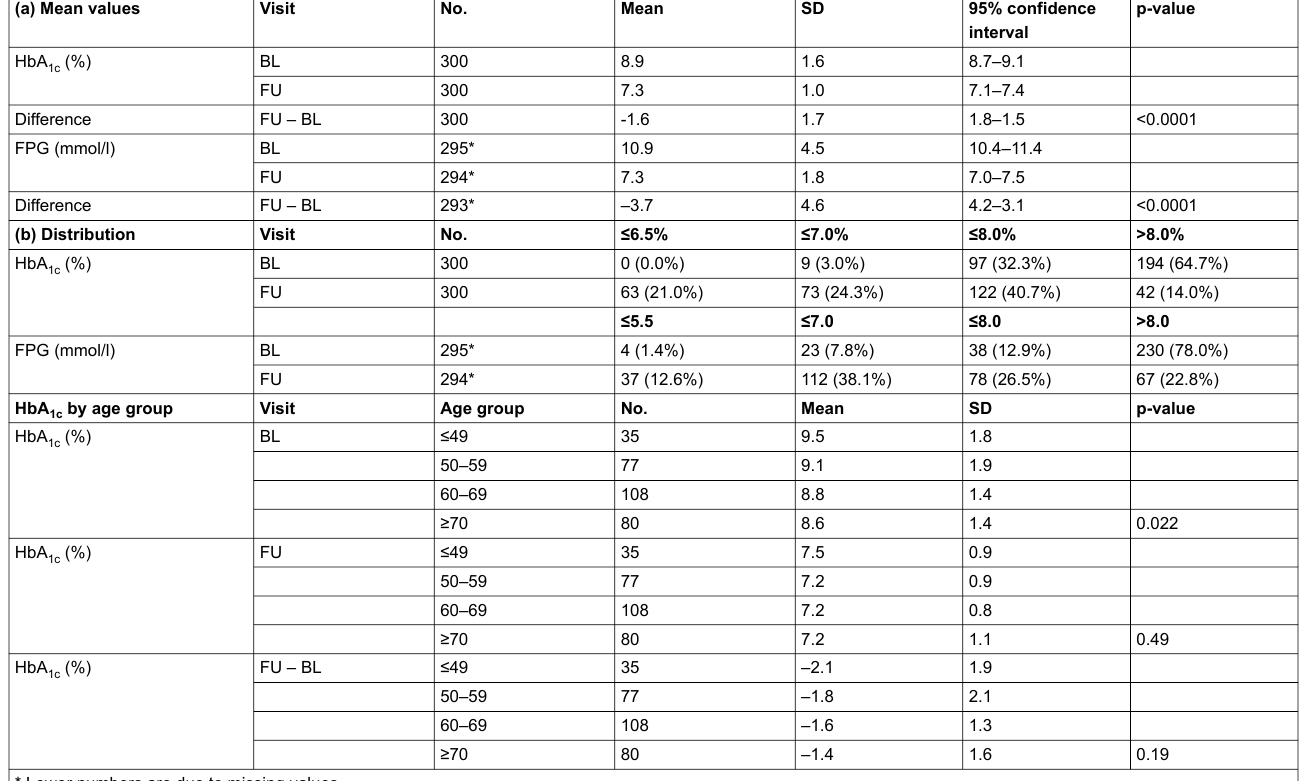
Table 4: (a) Mean (standard deviation; SD) HbA1c and fasting blood glucose (FPG) at baseline (BL) and follow-up (FU) visits. The paired differences in mean (SD) HbA1c and FPG from BL visit to FU visit after 6 months. The reported p-values were calculated using the paired t-test. (b) Number and frequency of patients allocated to defined groups of HbA1c and FPG levels at BL and FU visits. (c) Mean (SD) HbA1c by age group at BL and FU visits and mean change from BL visit to FU visit after 6 months. Figures represent the number and percent of patients of the per protocol population (n = 300). (a) Mean